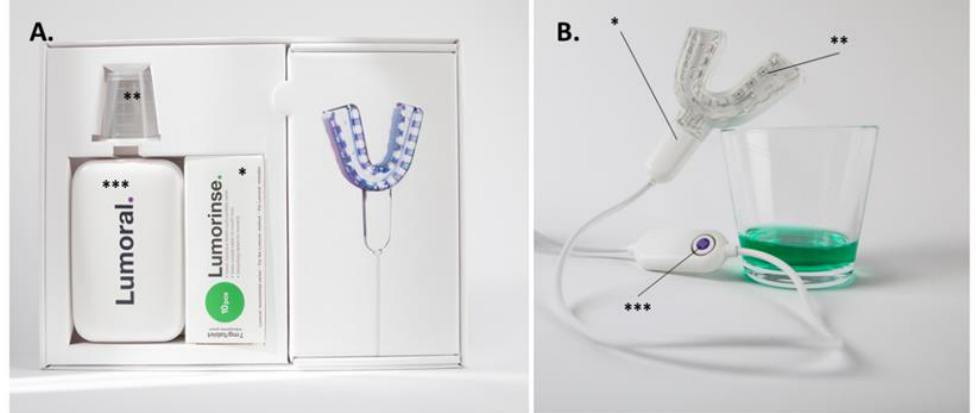
Figure 1. The dual-light aPDT device was used in the study. ( A ) The packaging provided for the study subjects included the effervescent ICG tablets (*) to be dissolved in 30 mL of water, for which a measuring cup (**) was provided. A power source (***) was provided for the mouthguard-type light applicator ( B ). The mouthpiece (*) is composed of 48 LED components (**) able to provide 405 nm and 810 nm light simultaneously. Symmetrically assembled LEDs provided light for both the maxillary and mandibular dental arches. The button on the control unit provided a treatment time of 10 min (***). Dissolved mouth rinse can be seen in the glass.